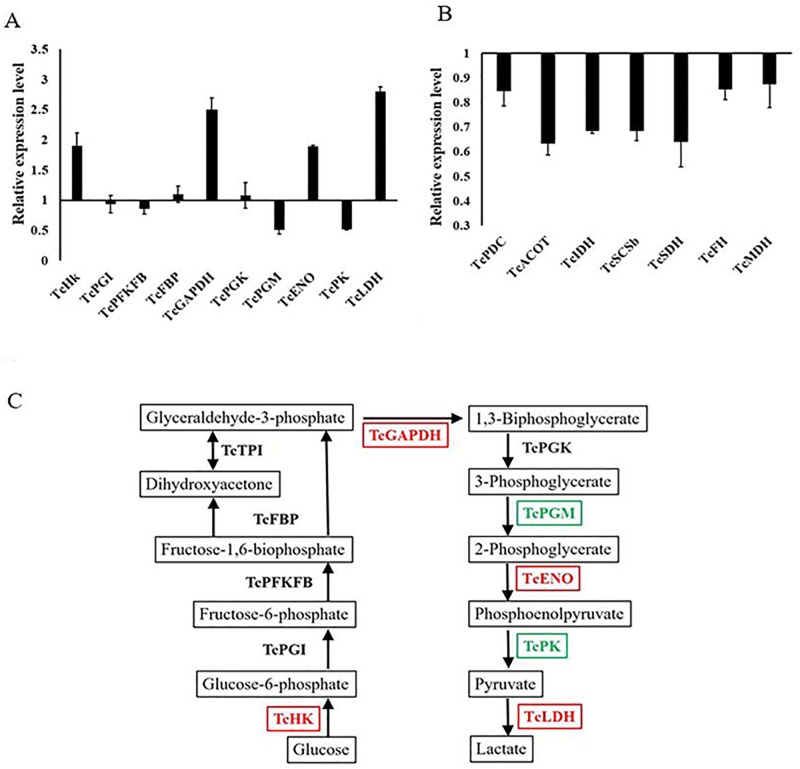
Gene expression pattern of glycolytic (A) and Krebs (B) cycle enzymes of Tribolium castaneum larvae in response to hypoxia.Total RNA was isolated from the larvae after 12 hours’ hypoxia treatment. qRT-PCR was used to illustrate gene expression. TcHK, hexokinase; TcPGI, phosphoglucose isomerase; TcPFKFB, 6-phosphofructo-2-kinase/fructose-2,6-bisphosphatase; TcFBP, fructose 1,6-bisphosphate aldolase; TcTPI, triosephosphate isomerase; TcGAPDH, glyceraldehyde-3-phosphate dehydrogenase; TcPGK, phosphoglycerate kinase; TcPGM, phosphoglycerate mutase; TcENO, Enolase; TcPK, Pyruvate kinase; TcLDH, L-lactate dehydrogenase; TcPDC, pyruvate dehydrogenase; TcACO, aconitate hydratase, mitochondria; TcIDH, isocitrate dehydrogenase; TcSCSb, succinyl-CoA synthetase beta chain; TcSDH, succinate dehydrogenase; TcFH, fumarate hydratase; TcMDH, malate dehydrogenase. Red color represents upregulate, green color represents downregulate and black color represents no change.